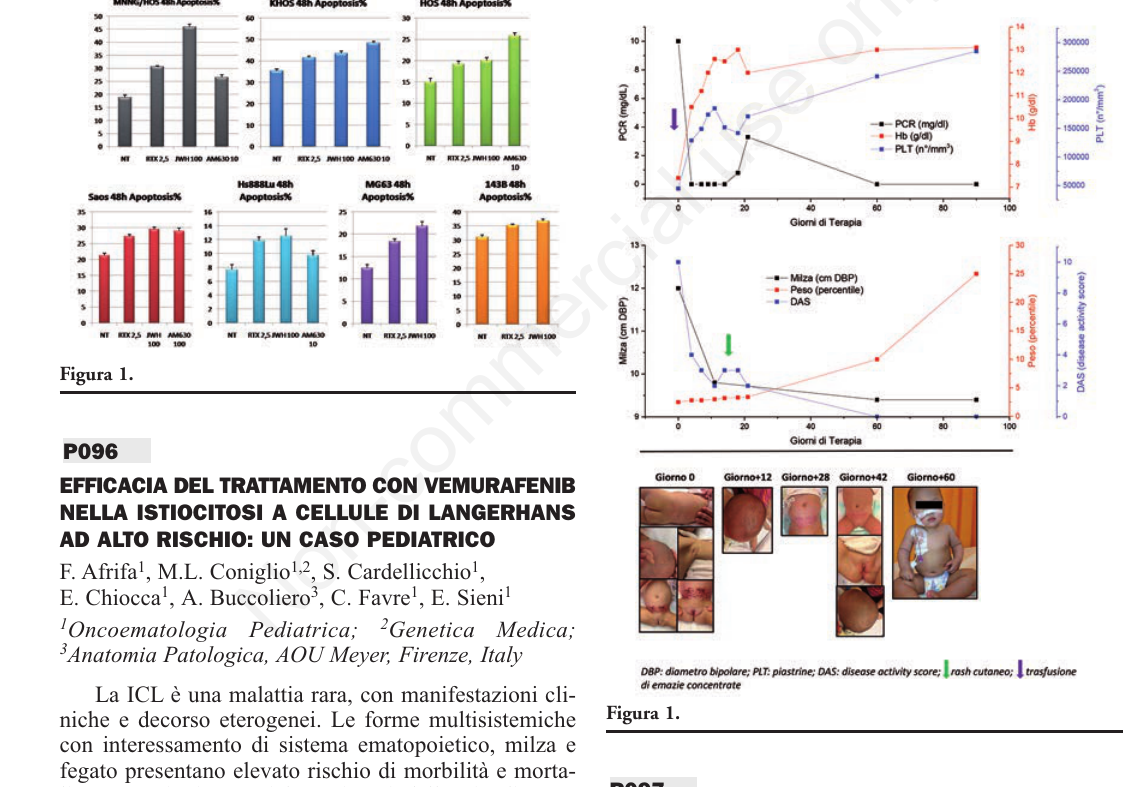
P097 TUMORE NEUROBLASTICO PERIFERICO E INVASIONE DEL CANALE